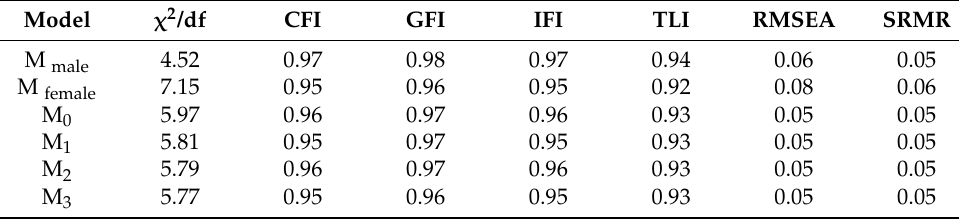
Table 5. Fitting index of multi-cohort model for multi-cohort analysis of gender